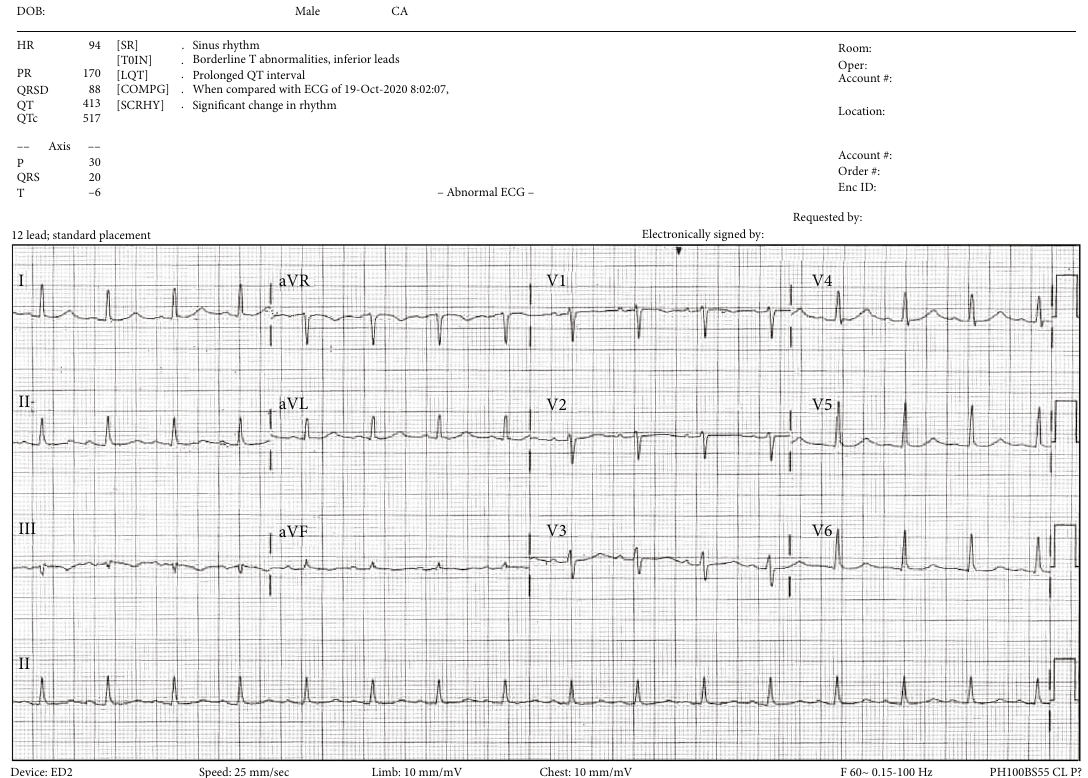
Figure 2: Second electrocardiogram following electrical cardioversion revealing return to normal sinus